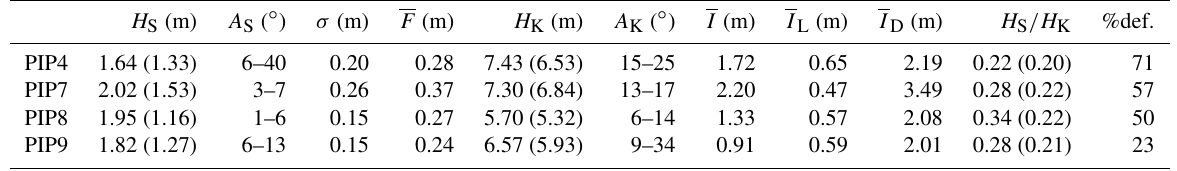
Table 1. Standard metrics calculated for PIPERS dataset: sail height ( H S ), sail angle ( A S ), surface roughness (here taken as the standard deviation of the snow freeboard, σ ), mean snow freeboard ( F ), keel depth ( H K ), keel angle ( A K ), mean thickness ( I ), mean level ice thickness ( I L ), mean deformed ice thickness ( I D ), sail-to-keel ratio ( H S /H K ) and % deformation. For H S and H K , the absolute maximum is given, along with the 99th percentile value of the deformed section draft (in brackets). The amount of deformed ice in each scan is generally high as the survey grids were deliberately chosen for their deformation. The sail and keel angles are not precisely defined because the deformed surfaces are complex and nonlinear, and a range of slopes across the deformed surface are